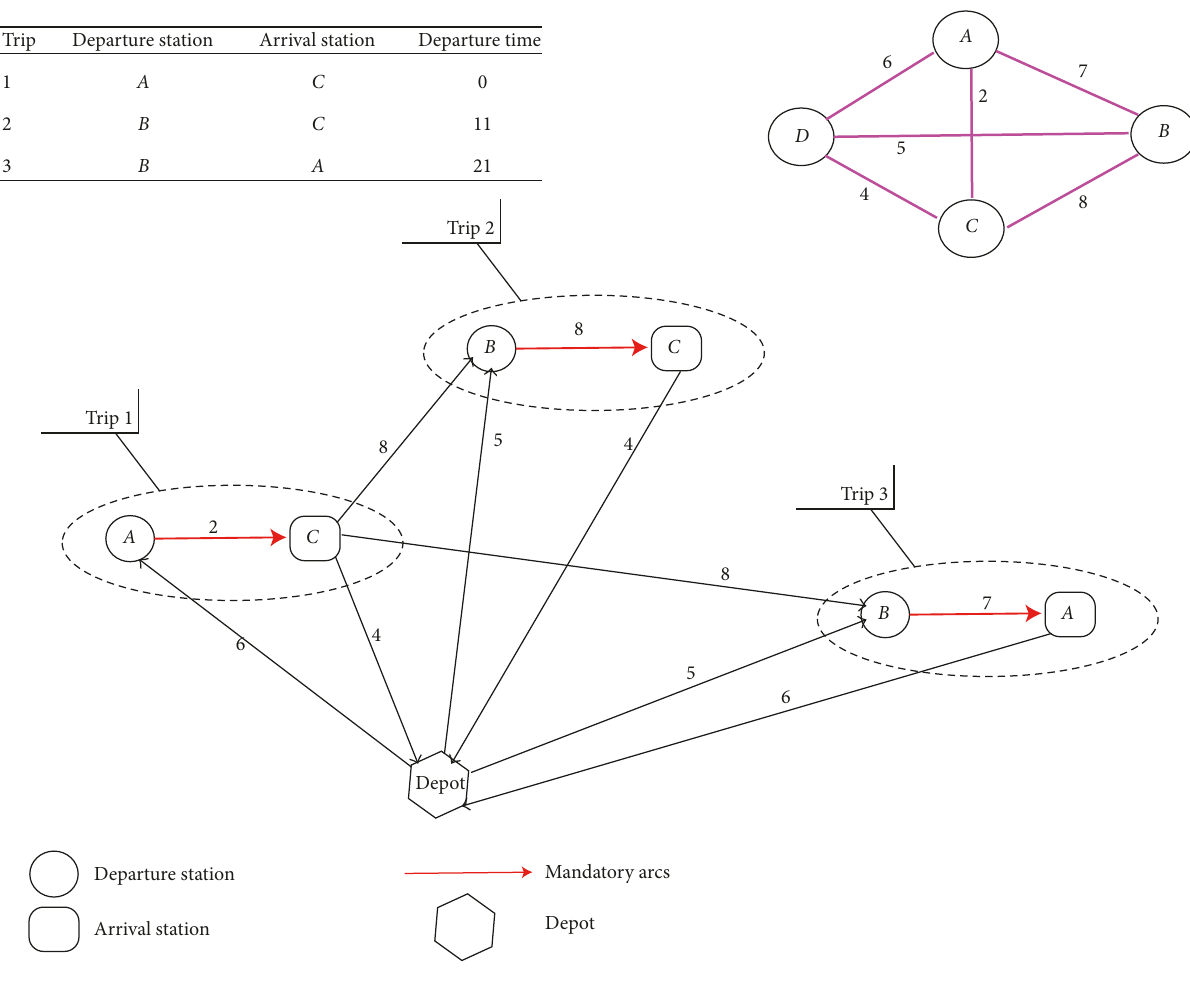
Figure 3: First illustrative